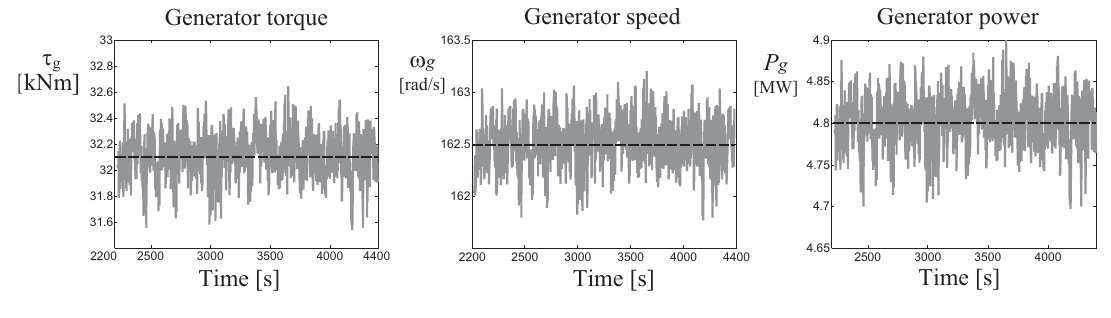
Figure 9. Variables of the benchmark in full load operation.